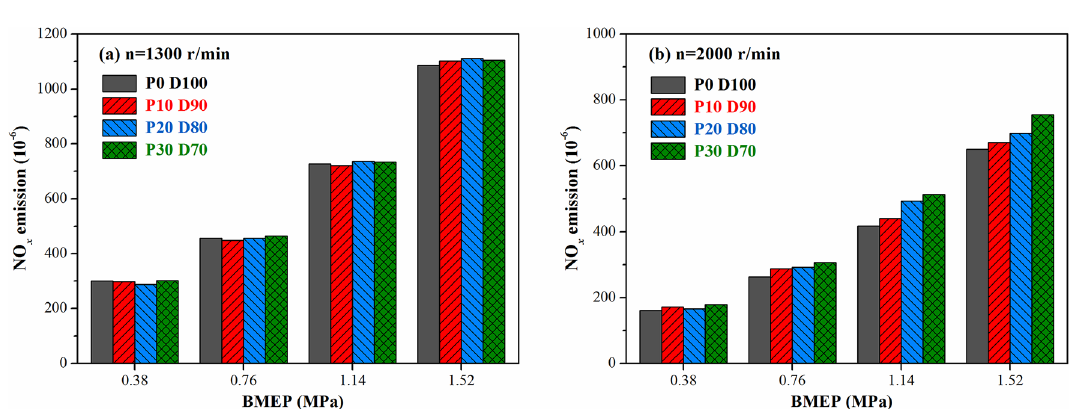
Figure 9. Effects of PODE n blending ratio on NO x